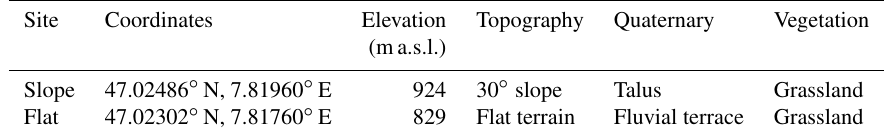
Table 1. Coordinates, topographical, geological, and vegetation characteristics of the two monitoring sites.